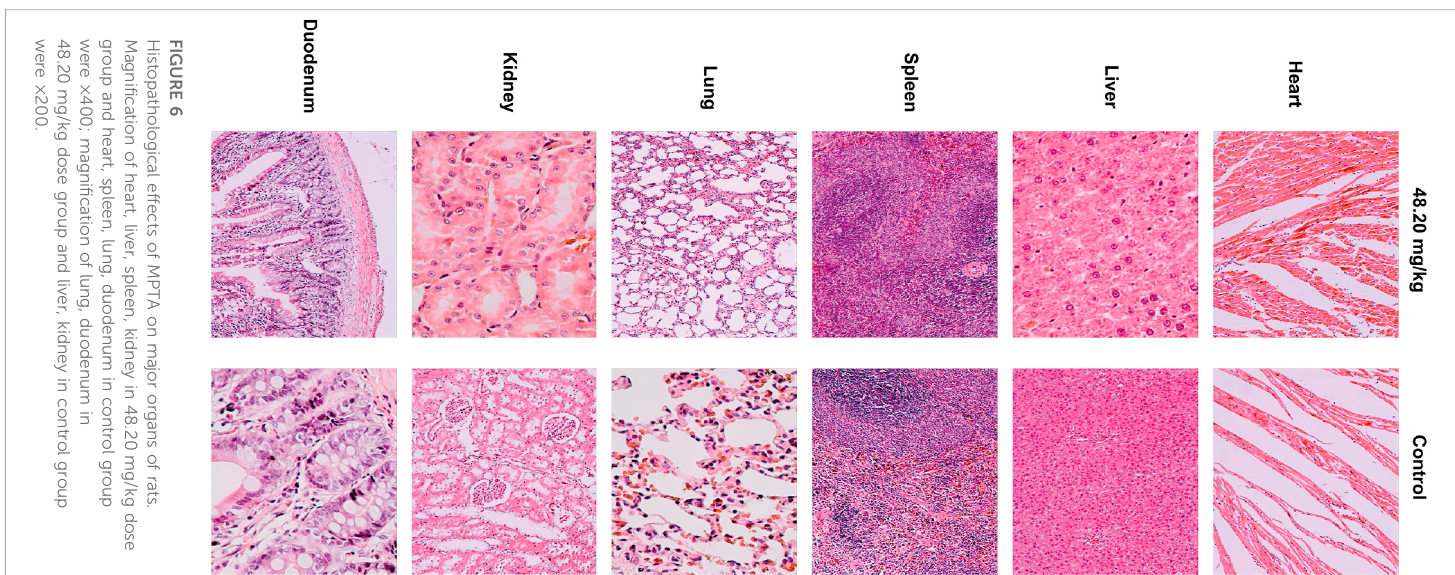
Lung Heart intestines